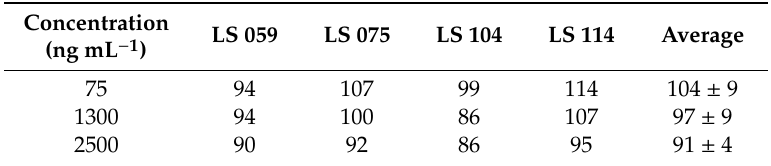
Table 4. Method recovery of β -ODAP extraction in di ff erent samples, at 75 (low concentration